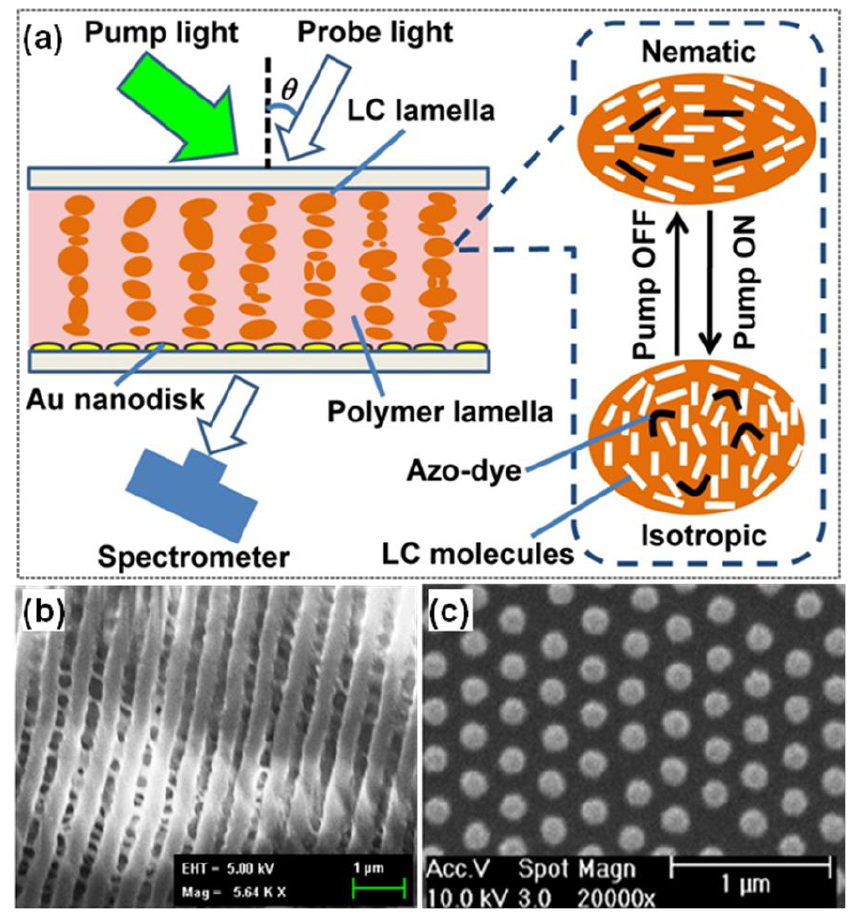
Figure 7. ( a ) Working principle of holographic polymer-dispersed liquid crystals (HPDLCs) transmission grating covered gold nanodisks. Modulation of resonance is realized by using a pumping light. The right part shows magnified view which demonstrates HPDLCs can be shifted between nematic and isotropic with pumping light off and on. ( b ) SEM topography of the HPDLCs transmission grating and ( c ) top-view SEM image of gold nanodisks fabricated by nanolithography followed by reactive ion etching with ~150 nm diameter and ~320 nm periodicity. Reproduced with permission from [109]. Copyright American Chemical Society, 2011.